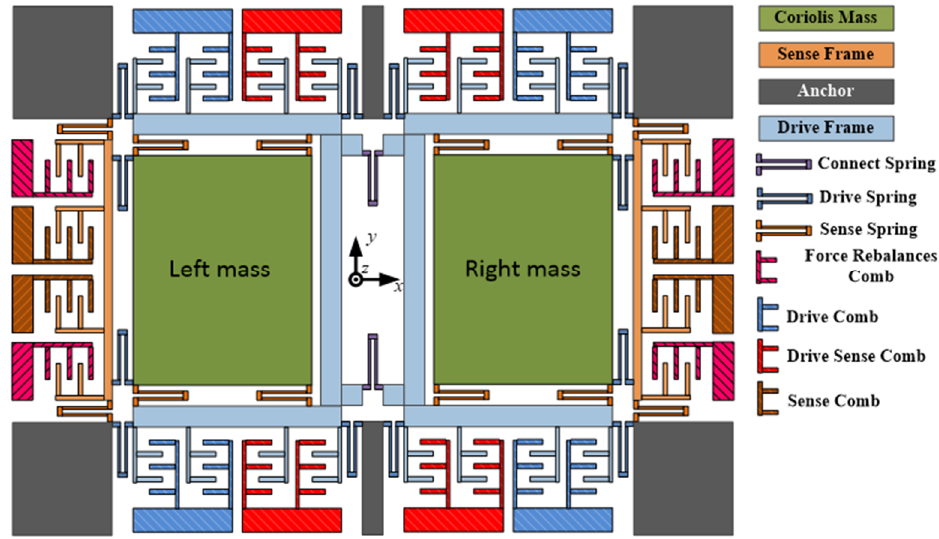
Figure 1. Schematic of the dual-mass gyro structure.